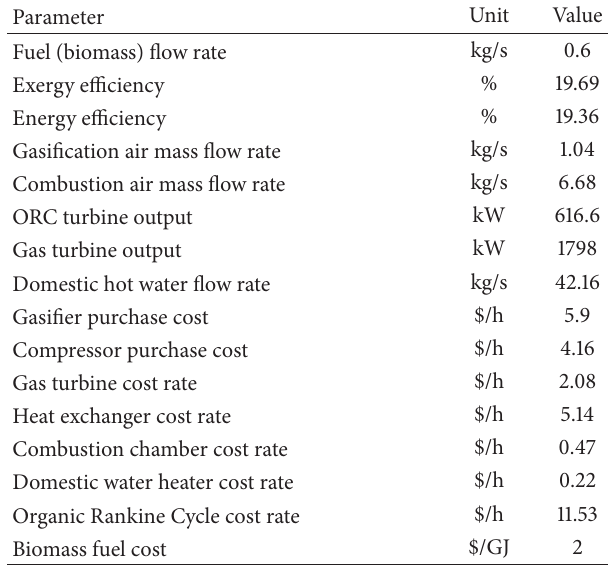
Table 4: Performance parameters of multigeneration system for the initial state.